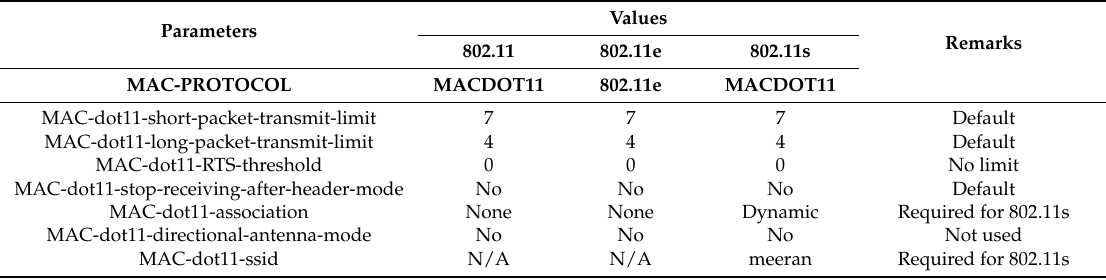
Table 5. IEEE 802.11/e/s and HWMP MAC configuration